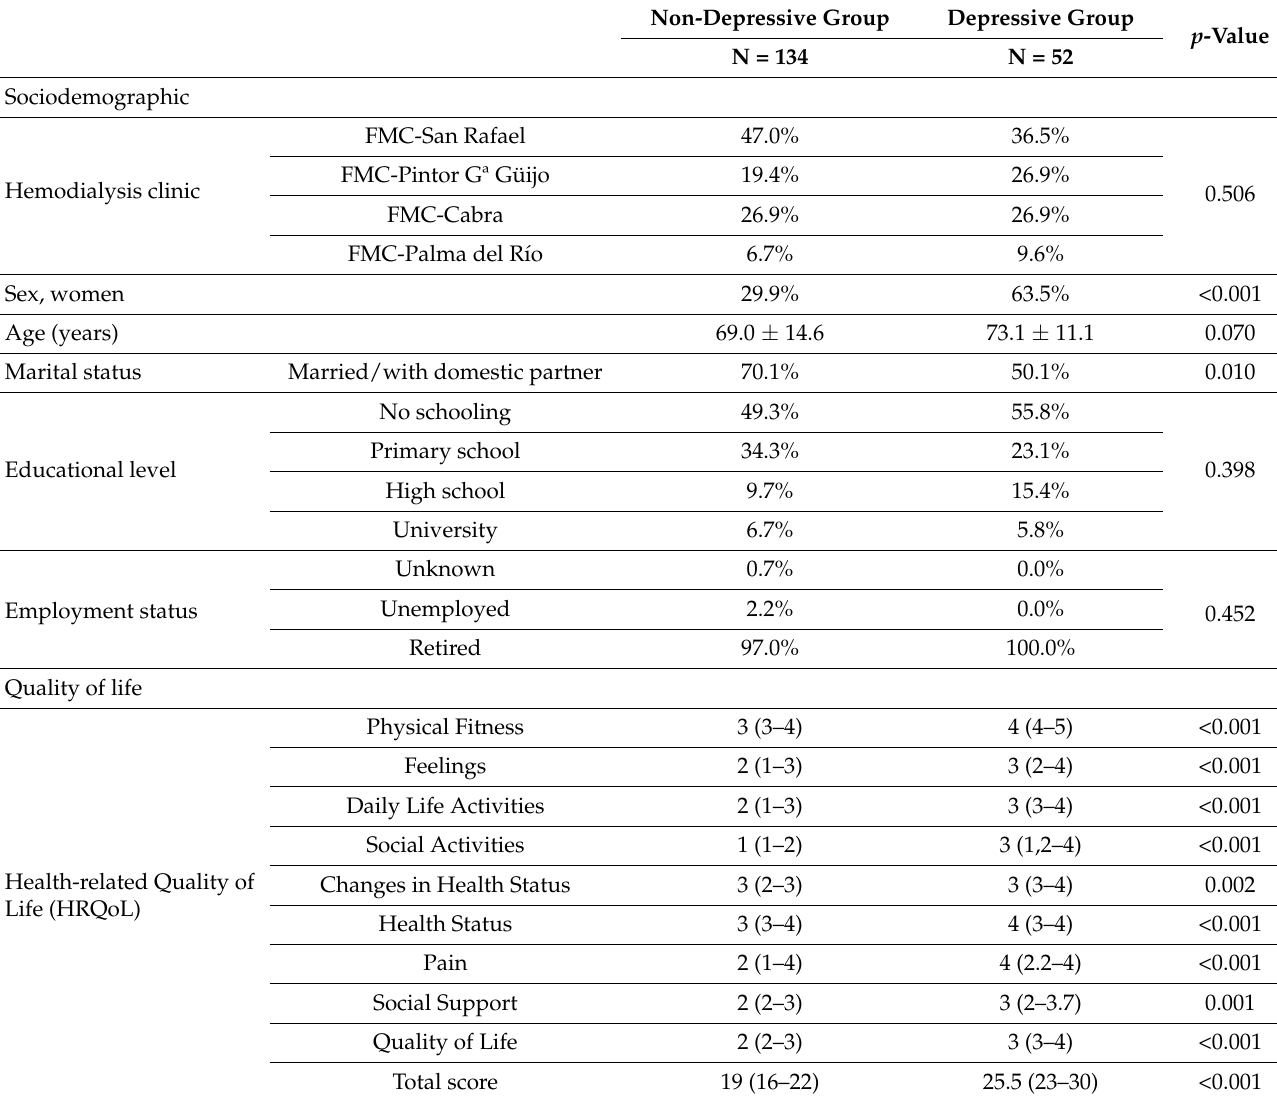
Table 1. Baseline characteristics of study population according to the depressive